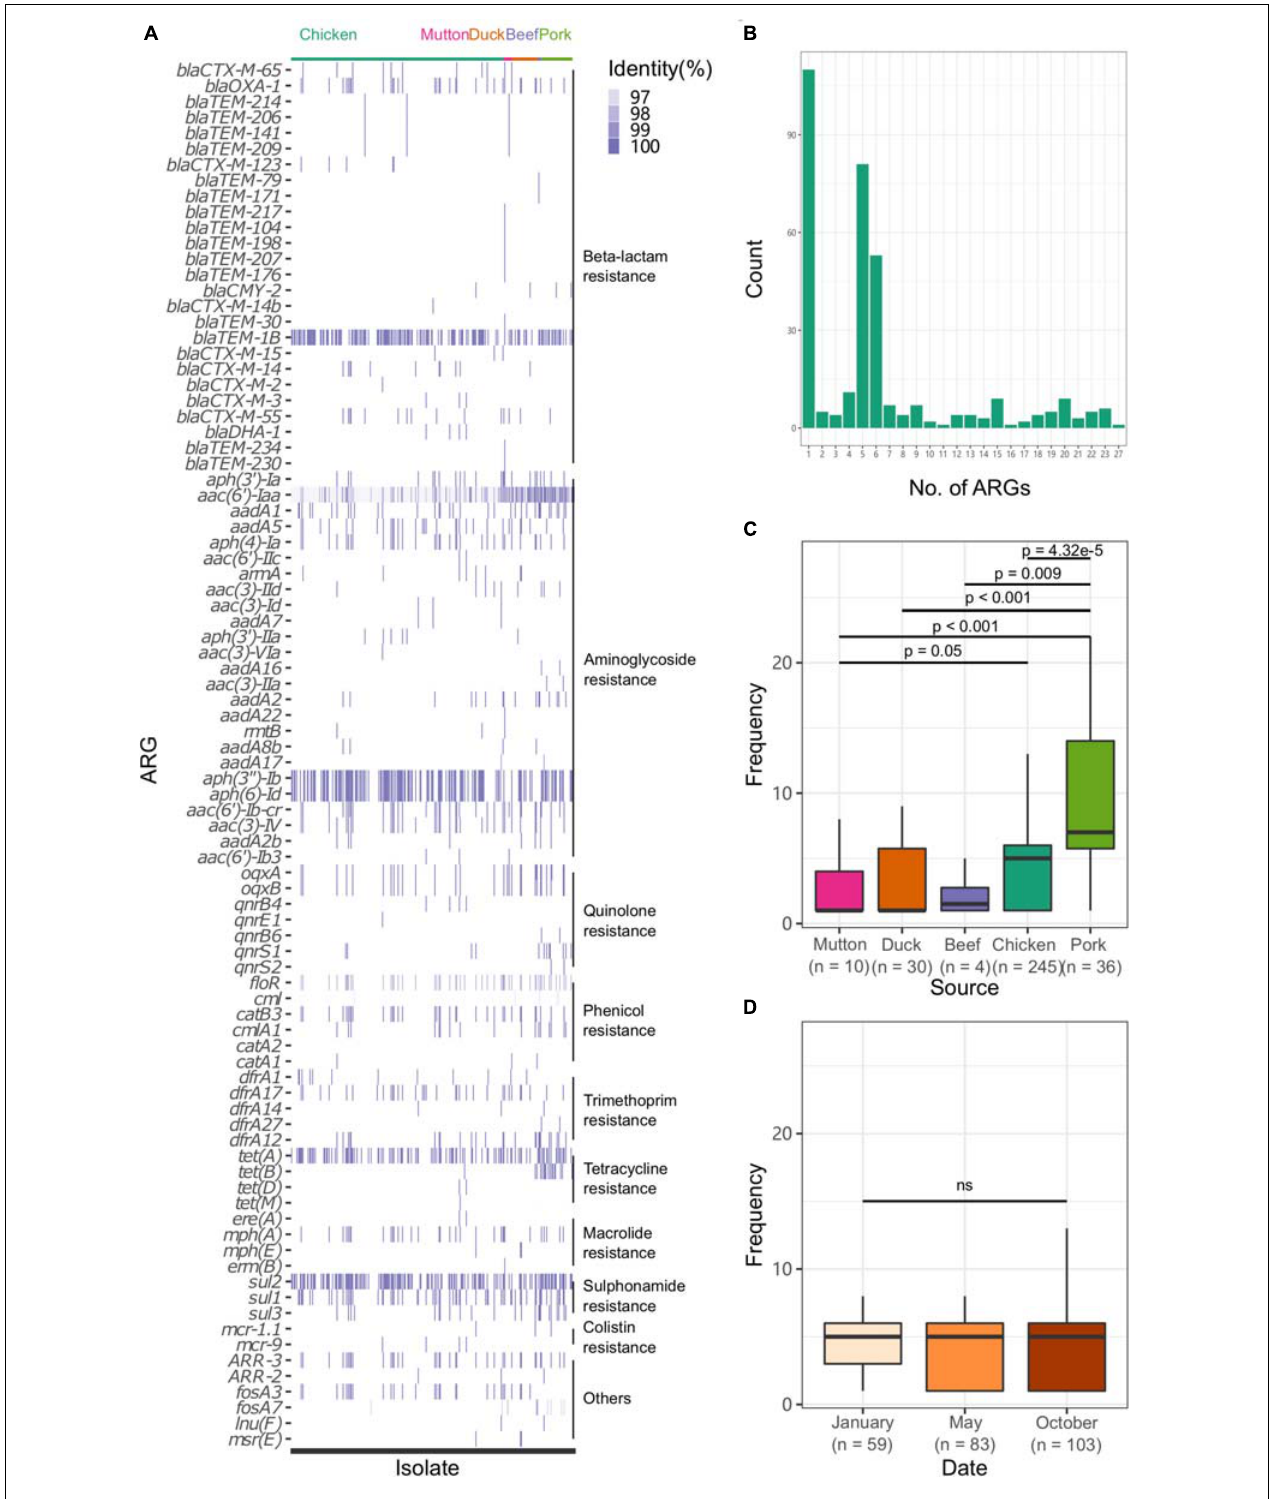
FIGURE 5 | Profile of ARGs in the Salmonella genome. (A) ARG profile in the Salmonella genome. (B) Number of ARGs in each genome. (C) Number of ARGs in the genomes of Salmonella isolates from different retail meats. (D) Number of ARGs in the genomes of Salmonella isolates from different sampling time points.